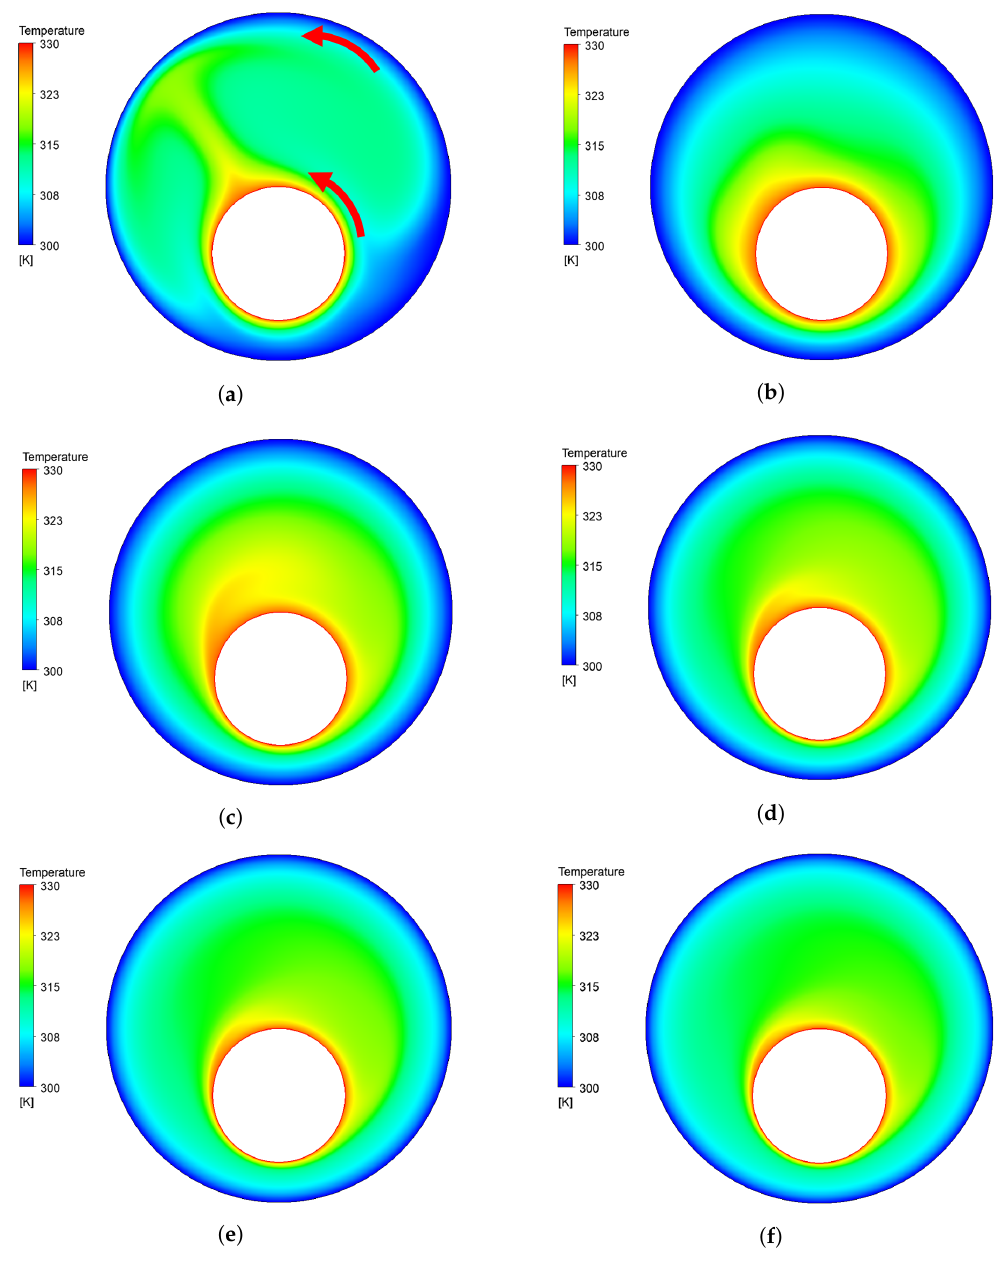
Figure 7. Numerical solutions for the inner–outer counterclockwise rotation with the same angular velocity: ( a ) 2 rad/s; ( b ) 5 rad/s; ( c ) 10 rad/s; ( d ) 15 rad/s; ( e ) 20 rad/s; and ( f ) 25